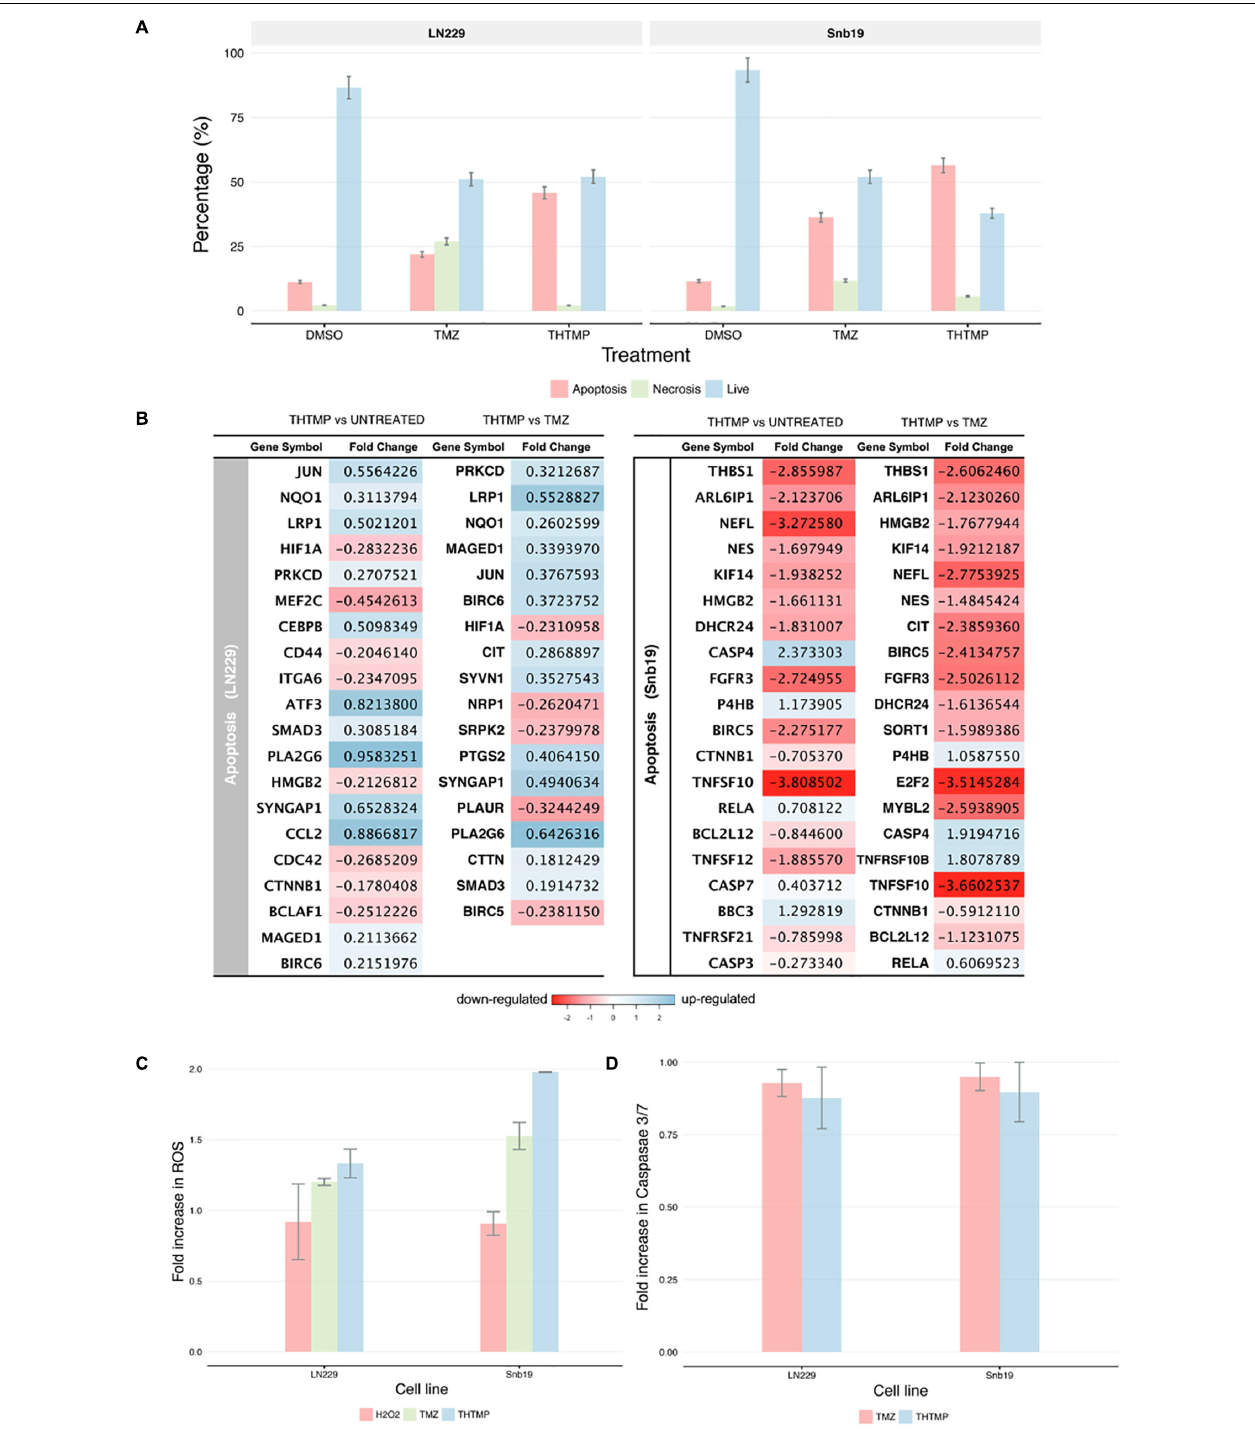
FIGURE 6 | Apoptosis induction determination using double stains Annexin V and Propidium iodide and RNA-seq. (A) Percentage of apoptosis, necrosis and live cell using Dead Cell Apoptosis Kit with Annexin V-FITC and PI of untreated cell (DMSO control TMZ and compound THTMP at 24 h post-treatment on Snb19 and LN229. (B) The top 20 DEGs which are involved in apoptosis of LN229 and Snb19. The DEGs were color coded, with the colors corresponding to the up- and down- expressed. (C) Effect of THTMP and TMZ in intracellular ROS production. Fluorescence intensity of ROS was determined by activity of 2 µ M H2DCFDA (30 min), fluorescent probe. H 2 O 2 was used as the positive control. (D) Activity of caspases 3/7 in LN229 and Snb19. Caspase 3/7 was determined using luminescence plate reader. Fold increase in ROS and caspases 3 and 7 activity of LN229 and Snb19 cell lines was calculated when they were treated with THTMP and PC at IC 50 concentration. Triplicates were performed for each